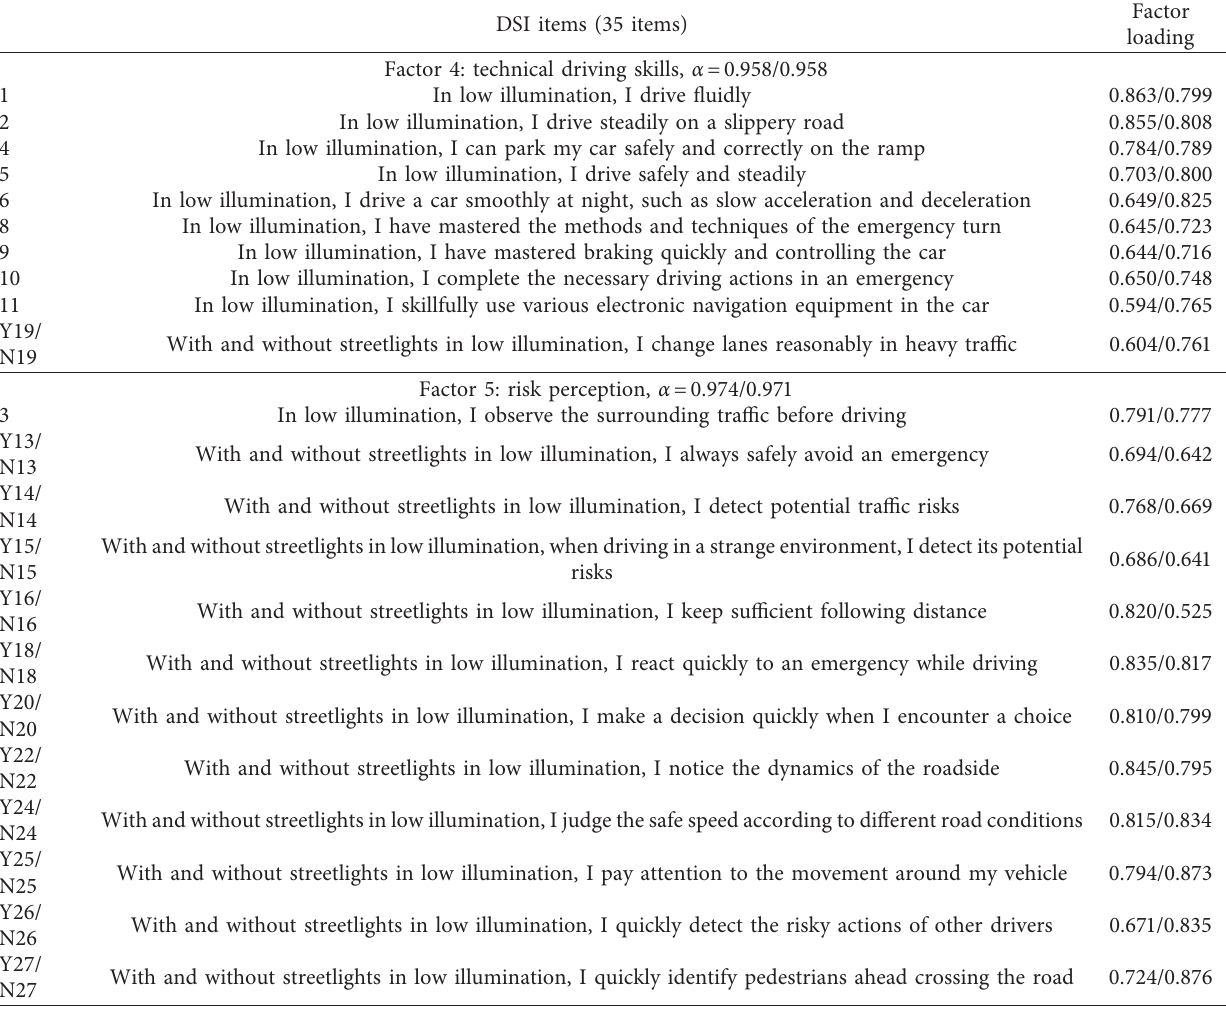
Table 7: Factor structure of the DSI items.